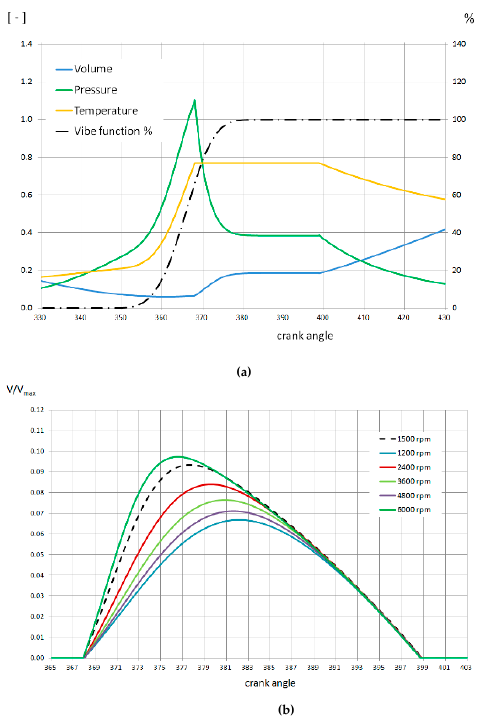
Figure 5. ( a ) A fragment of the parameters V, p, T, and the Vibe function for the proposed theoretical cycle in the form of an open diagram for cr = 17:1, ( b) required reaction of the complementing system cr 17:1 as a function of rotational speed (rpm).